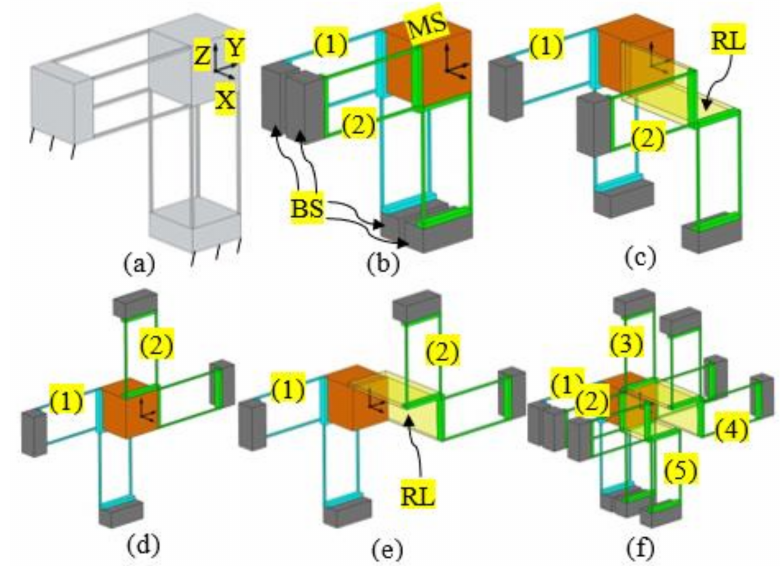
Figure 1. Position-space-based reconfiguration of a general one degree of freedom (1-DOF) translational compliant mechanism: ( a ) original 1-DOF translational compliant mechanism; ( b ) decomposition of the 1-DOF translational compliant mechanism; ( c ) change of geometrical dimension; ( d ) change of geometrical shape; ( e ) changes of both geometrical dimension and geometrical shape; and ( f ) addition of redundant compliant modules (MS: motion stage, BS: base stage, RL: rigid link, compliant modules are labelled by numbers (1) to